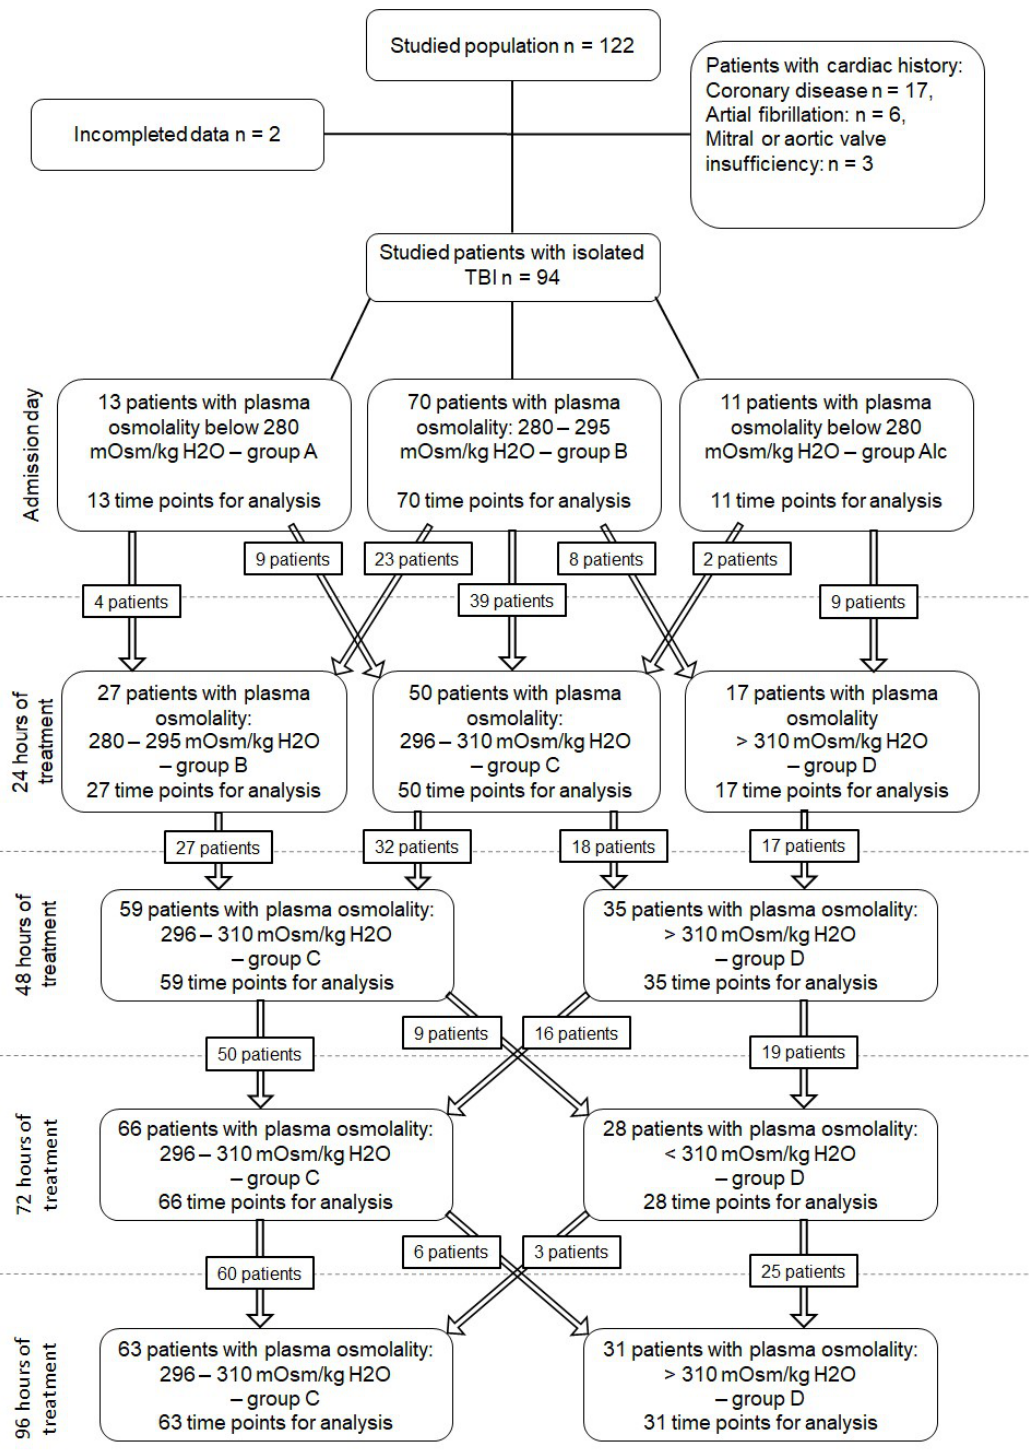
Figure 1. Patient distribution according to plasma osmolality. Taken together, plasma osmolality <280 mOsm / kg / H 2 O was noted in 13 patients on the admission day (13 time points); between 280 – 295 mOsm / kg H 2 O in 97 patients at least once during the five studied time points (97 time points); between 296–310 mOsm / kg H 2 O in 238 patients at least once during the five studied time points (238 time points); and > 310 mOsm / kg H 2 O in 111 patients at least once during the five studied time points (111 time points). Positive blood alcohol was found in 13 patients on admission day.